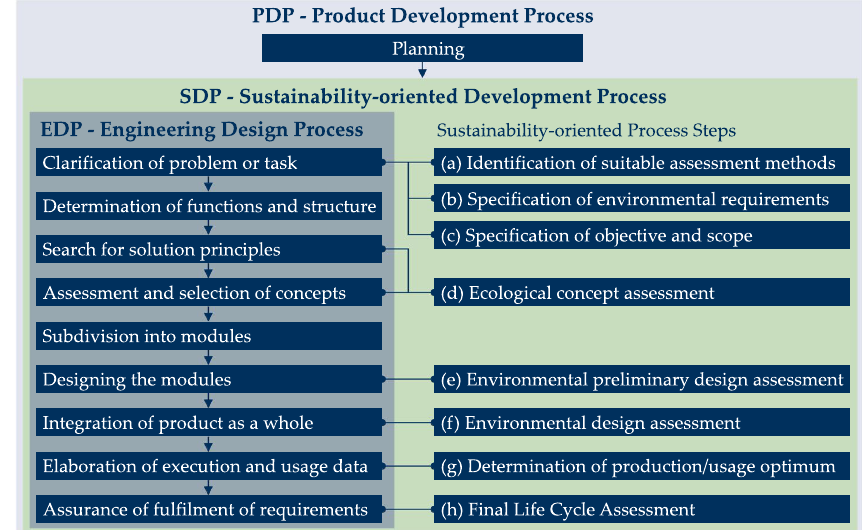
Fig. 6 Process flow and contents of the